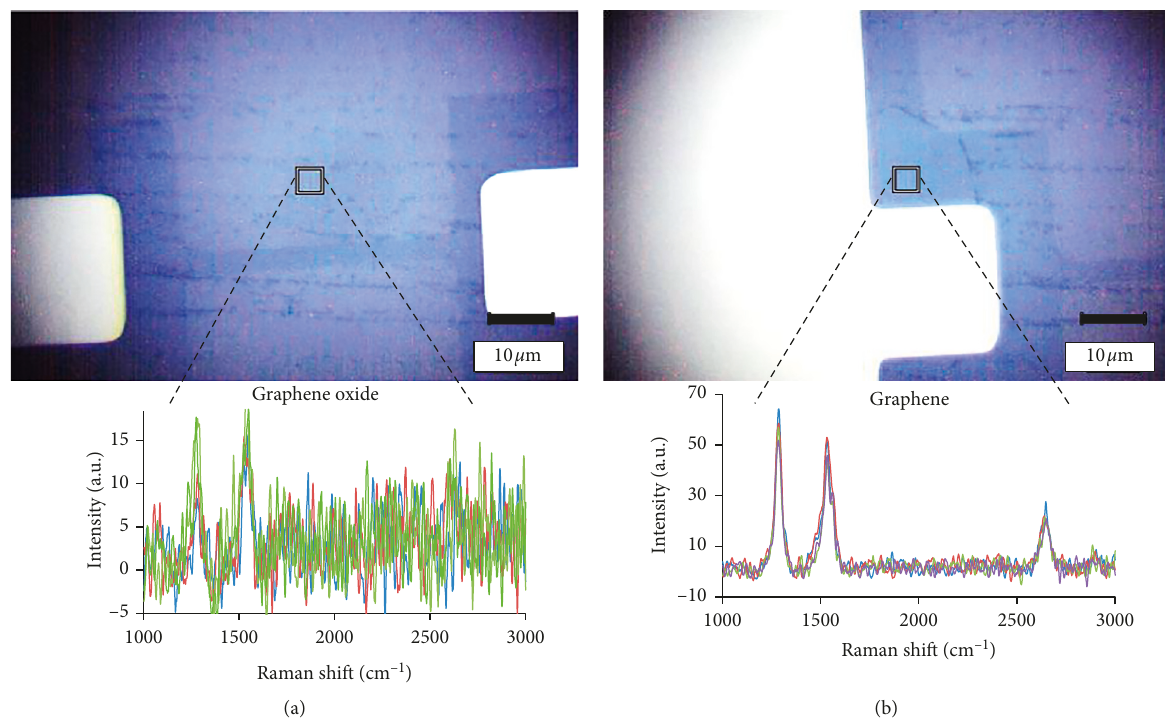
Figure 3: Raman characteristic (514nm wavelength) of (a) graphene exposed to oxygen plasma (8 Watts, 30mTorr, 1sccm, 2 minutes) and (b) pristine graphene. The spectrum was measured on each corner point of a (4 µ m) 2 square area. The Raman characteristic of plasma-etched graphene corresponds to that of graphene oxide.